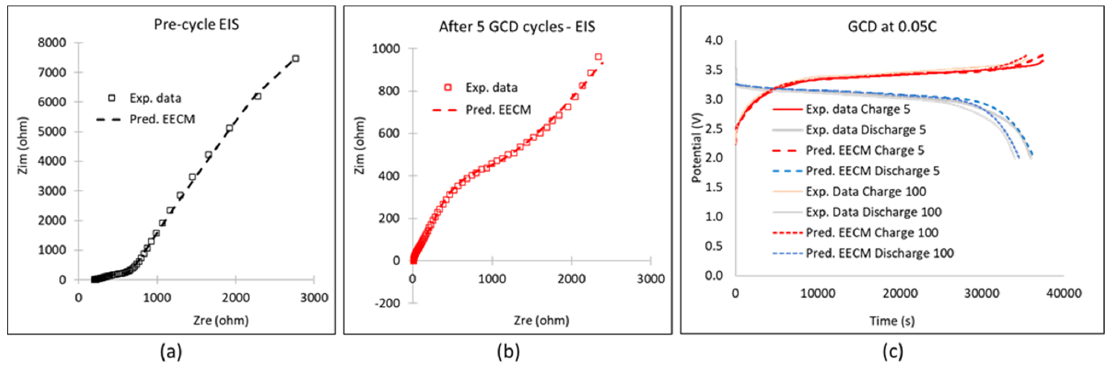
Figure 11. Comparisons of the predictions applying the EEC model (EECM) with experimental data from the testing of a graphite-LPF cell (with KynarFlex ® PVDF 2801-00 binder in the cathode): ( a ) Nyquist plot showing the fit of the EEC model with the pre-cycling EIS data; ( b ) Nyquist plot showing the fit of the EEC model with the EIS data after five GCD cycles; ( c ) comparison between predictions of the EEC model and experimental data for the fifth and 100th GCD cycle at 0.05 C.